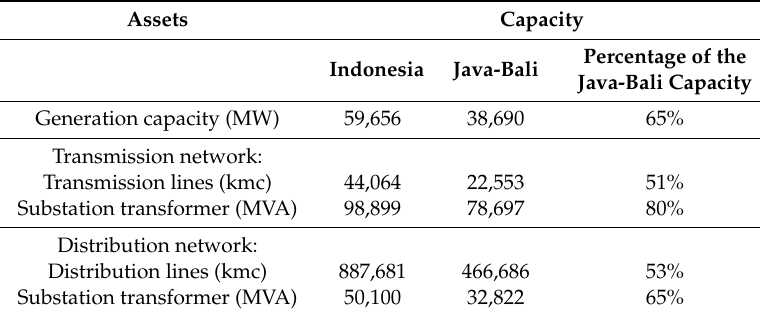
Table 1. Capacities of power generation, transmission, and distribution: total Indonesia and Java-Bali power system